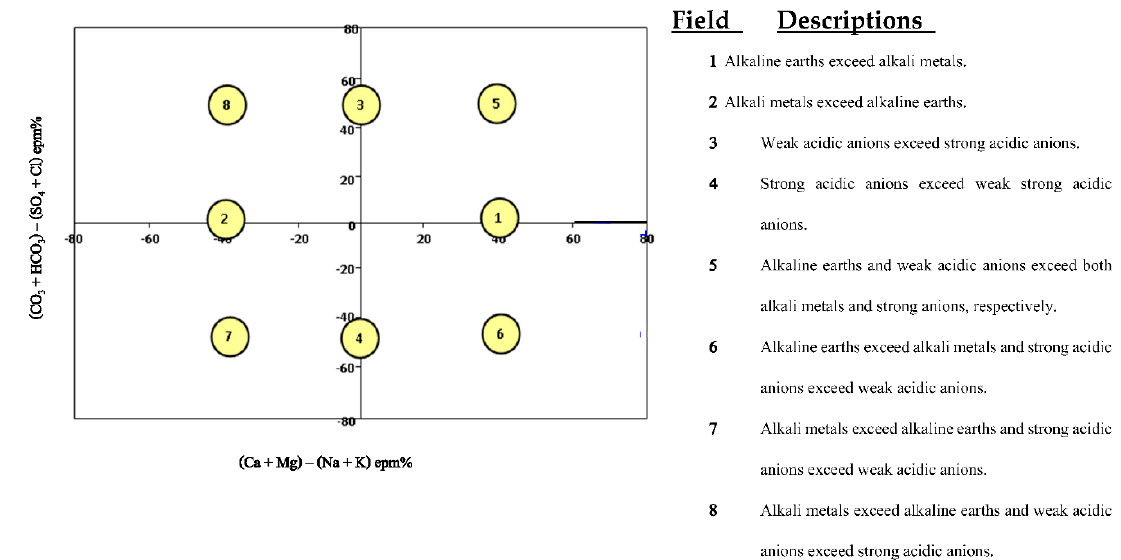
Figure 3. Water type according to Chadha classification in the study area .